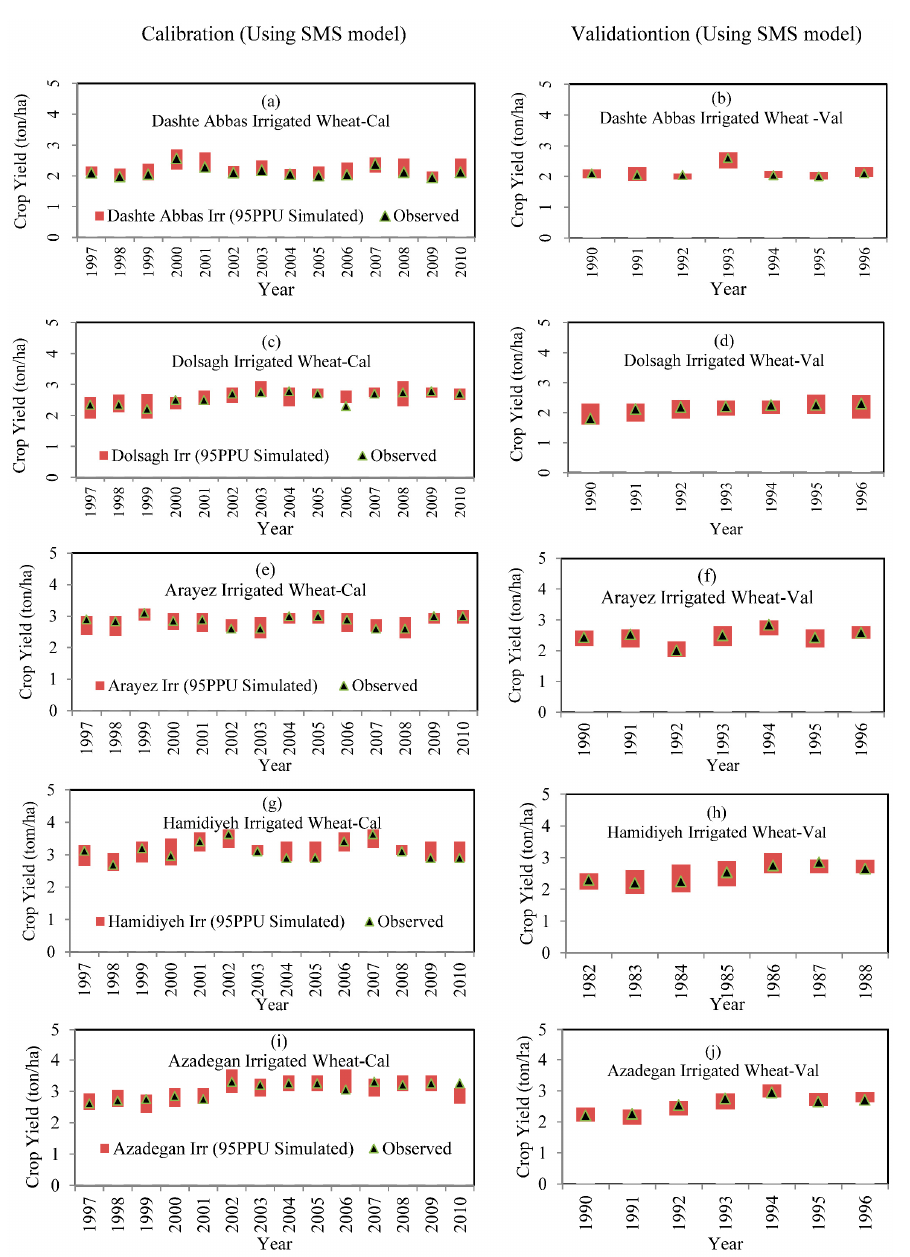
Figure 5. Results of the SWAT calibration and validation for wheat yield in Dashte Abbas ( a , b ), Dolsagh ( c , d ), Arayez ( e , f ), Hamidiyeh ( g , h ), Azadegan ( i , j ) plains.